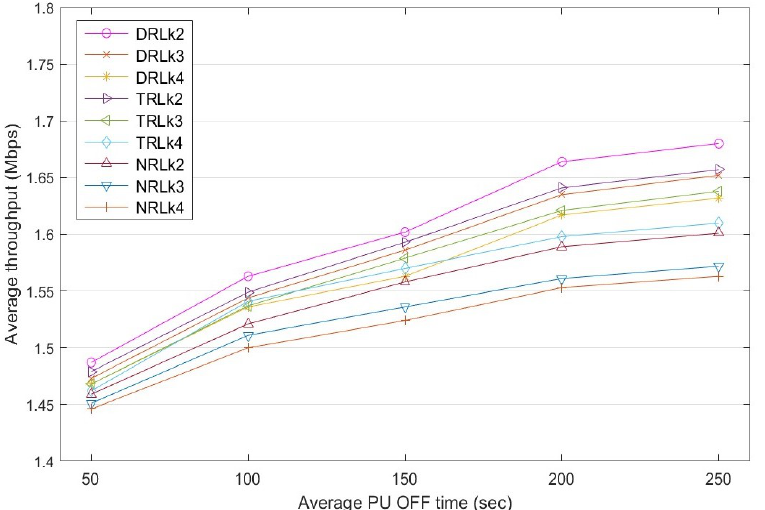
Figure 11. Average throughput comparison among routes k 2 , k 3 , and k 4 for dynamic RL with dynamic α , traditional RL with α = 0.5 and non-RL at a different PU OFF